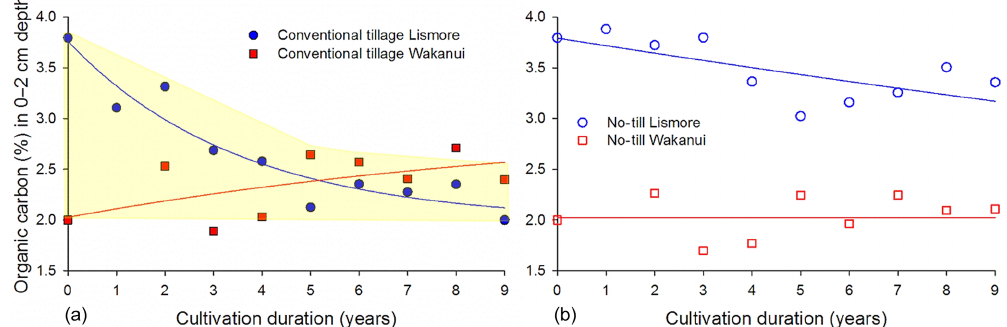
Figure 10. Nine years of continuous cropping and conventional tillage (a) led to similar soil organic carbon (SOC) contents in contrast to no- till soils (b) (Francis and Knight, 1993). The Lismore no-till soil either needs longer cultivation duration to reach the C content characterizing soils under conventional tillage or the attractor of SOC has already been reached, i.e. local minima for this soil. Note that the Wakanui no-till soil was cultivated for 10 years before beginning the trial and thus shows similar values, i.e. similar attractor for SOC as under conventional tillage. Thus, changing the conventional tillage to no-till had no effect on SOC content. Lismore soil is an Umbric Dystochrept, containing 5% stones, with rapid draining, which was cultivated for 5 years under mixed rye grass and white clover pasture. Wakanui soil is an Udic Ustochrept, with slow draining, and 10-year rotation of wheat, barley and